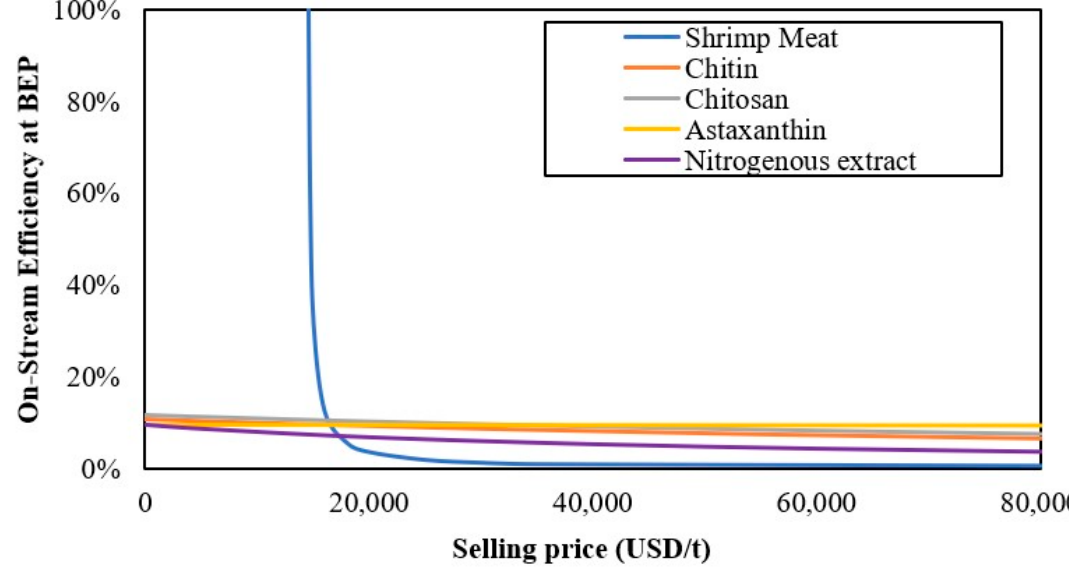
Figure 4. The e ff ect of the selling price on on-stream e ffi ciency.